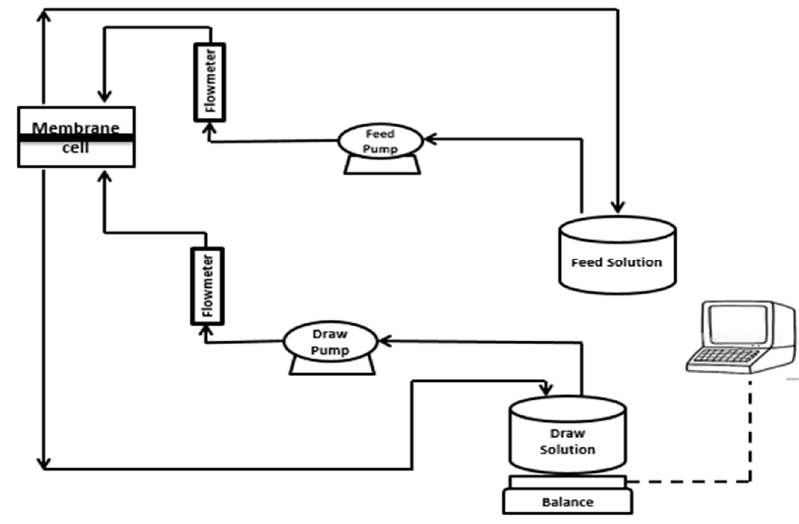
Figure 2. The flow diagram for the forward osmosis (FO) system.